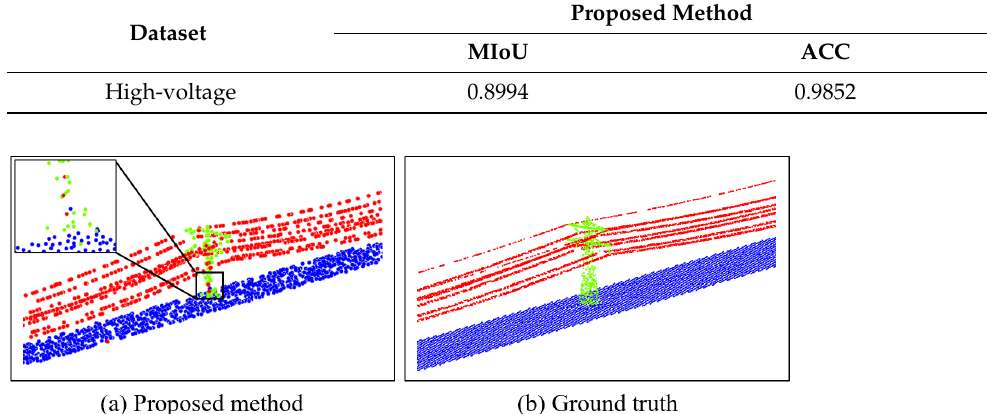
Figure 22. The results of proposed powerline segmentation methods. The powerline, pylon, and ground are colored with red, green, and blue, respectively. The black dotted frame indicates points that are classified by